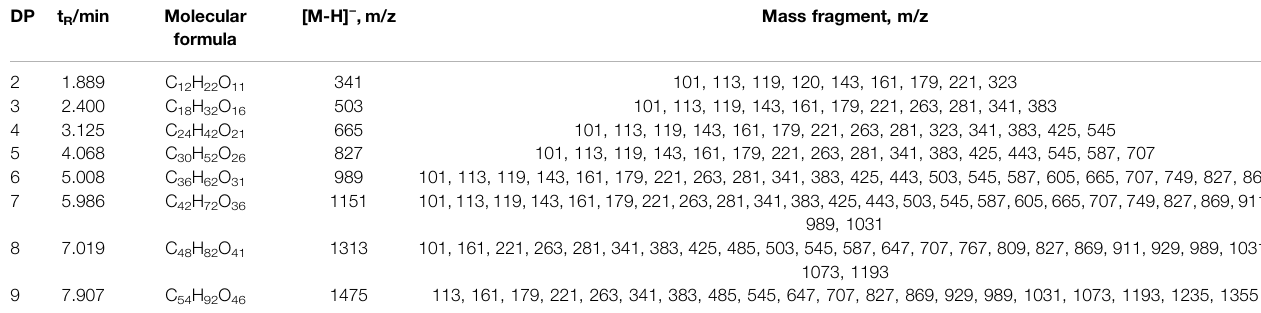
TABLE 4 | Mass spectrometric data of two to nine sugars in APOS. DP t R